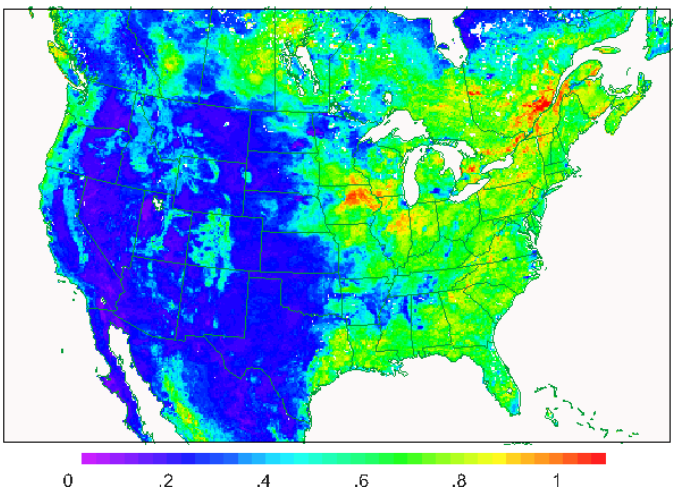
Figure 6. Ozone dry deposition velocity (cm/s) from a 12 km grid resolution CMAQ simulation on 25 July 2006 at 19 UT.